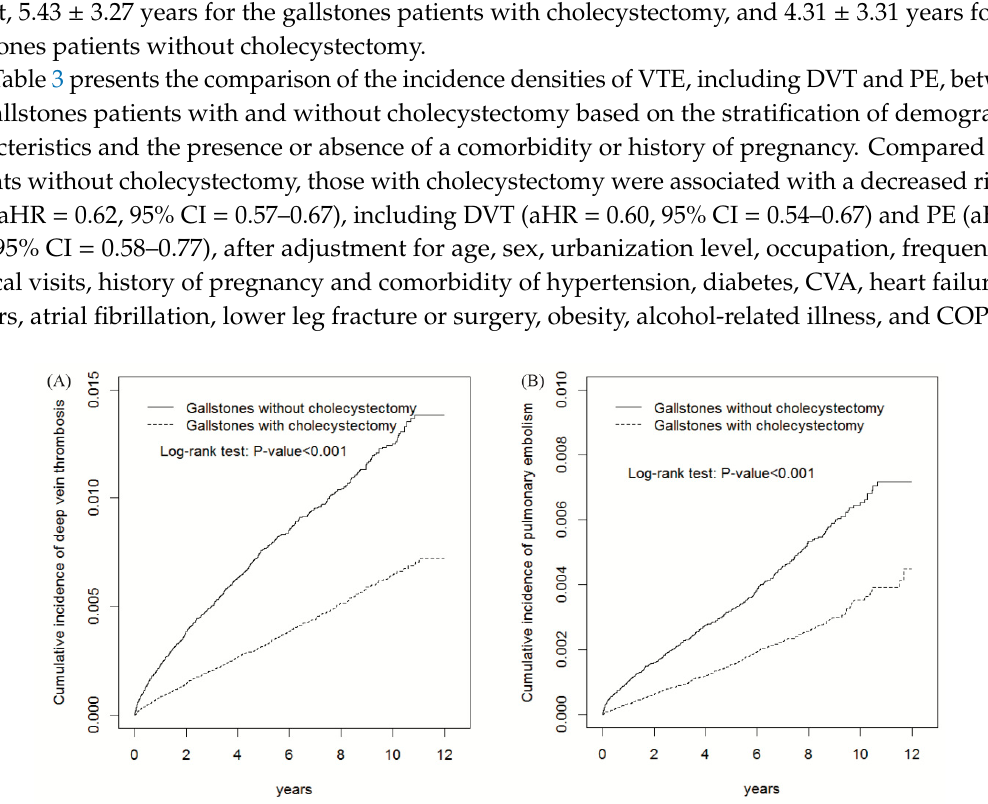
Figure 1. The cummulative incidence of deep vein thrombosis (DVT) and pulmonary embolism (PE) in gallstones patients with cholecystectomy and without cholecystectomy.